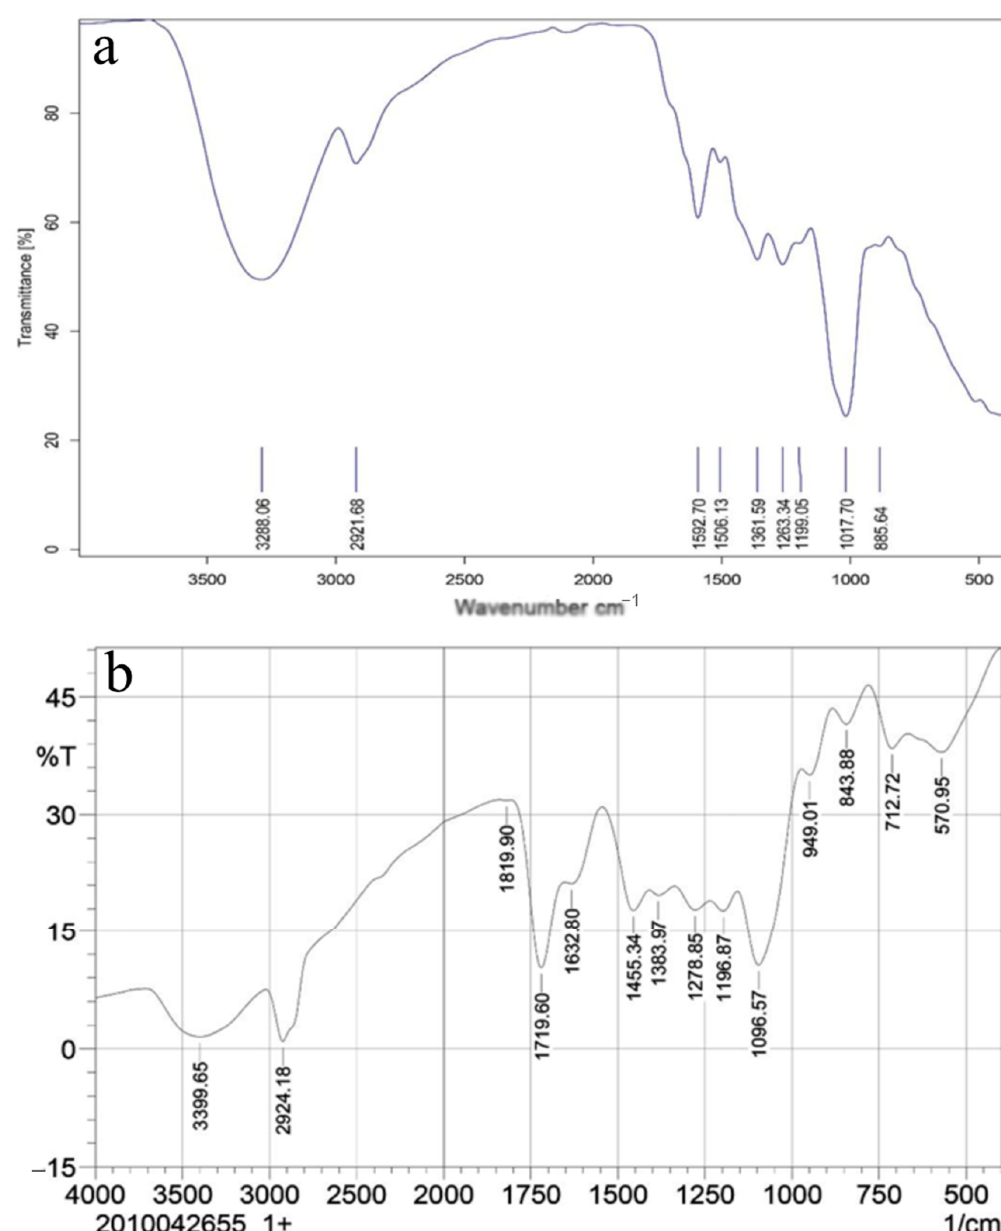
Figure 4: FT-IR of ( a ): PPEE, ( b ) PPEE-SLNs with similar characteristic peaks indicating no significant interaction between PPEE and the lipid.